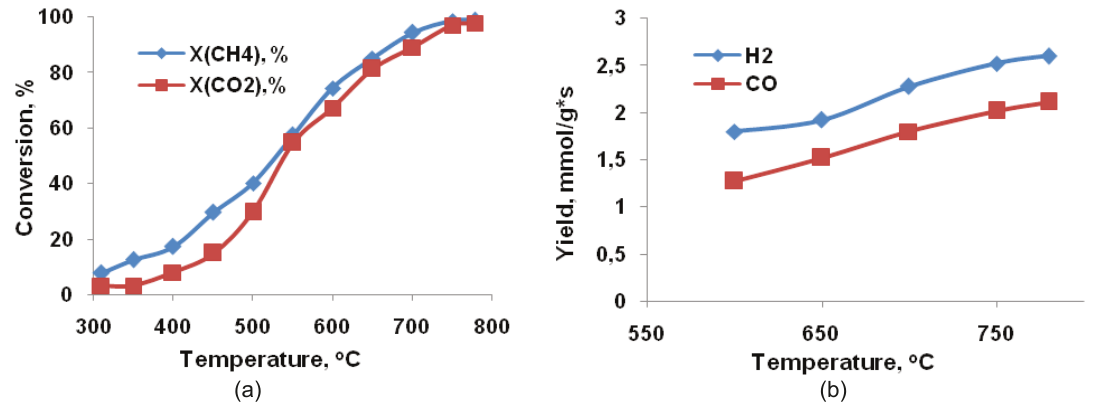
Figure 1. Effect of temperature on the dry reforming of biogas over the 5%(Co-M